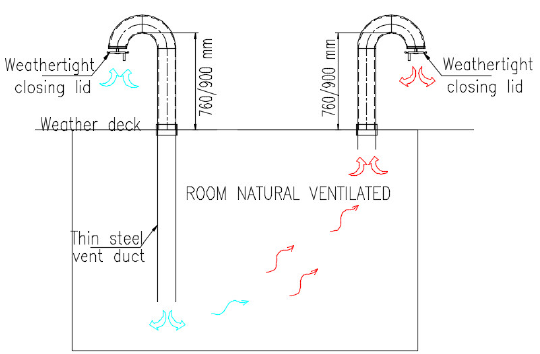
Figure 1. General arrangement. Independent natural ventilation for a room located below the weather deck.